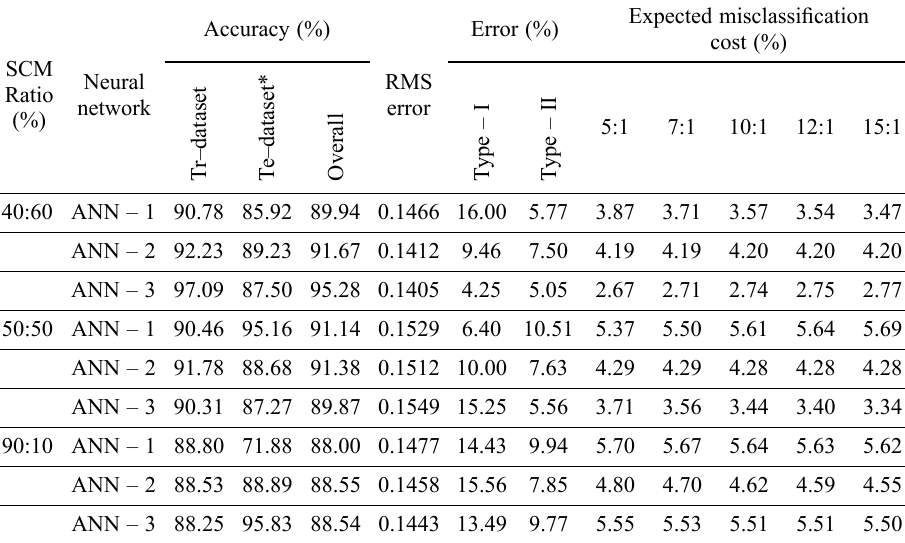
Table 5. Performance obtained by the Japanese database